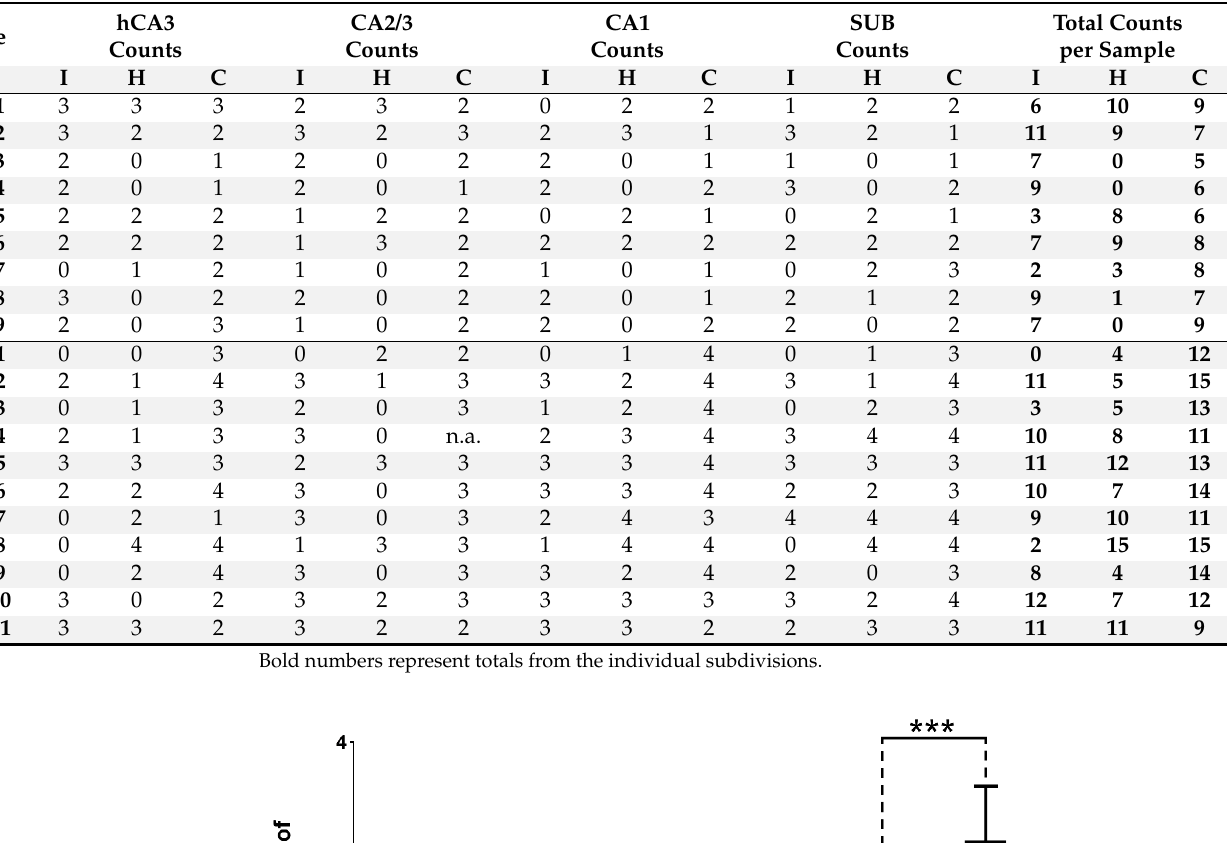
Table 5. Results of the semiquantitative scale assessment of microglial markers IBA1 (I), HLA-DR (H), and CD68 (C).